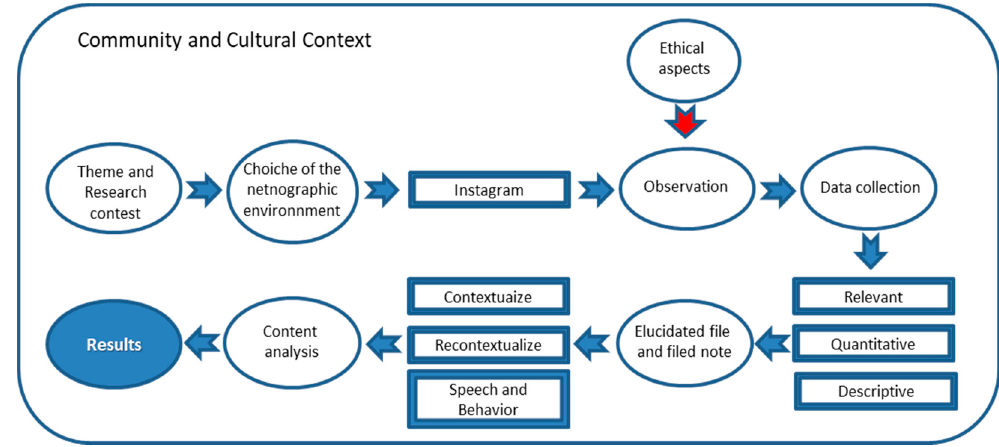
Figure 1. Authors’ representation of the Netnographic approach applied in the study.